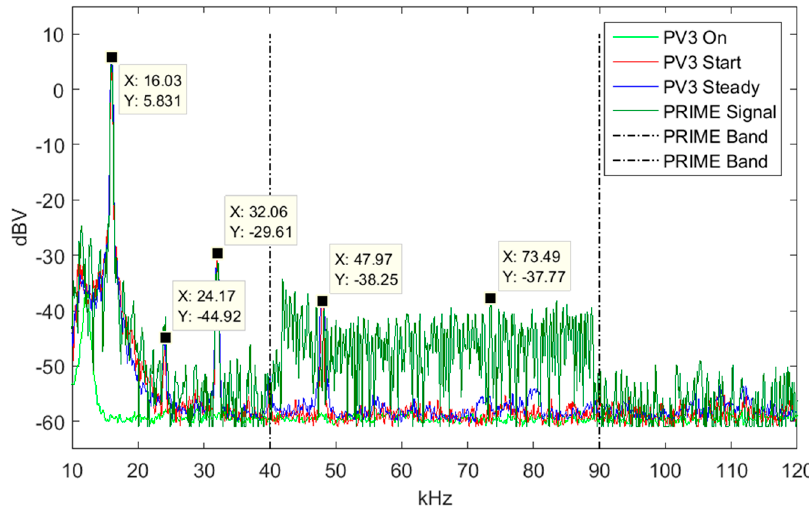
Figure 11. Spectrum recorded at the PV3 SM with the rest of devices disconnected.